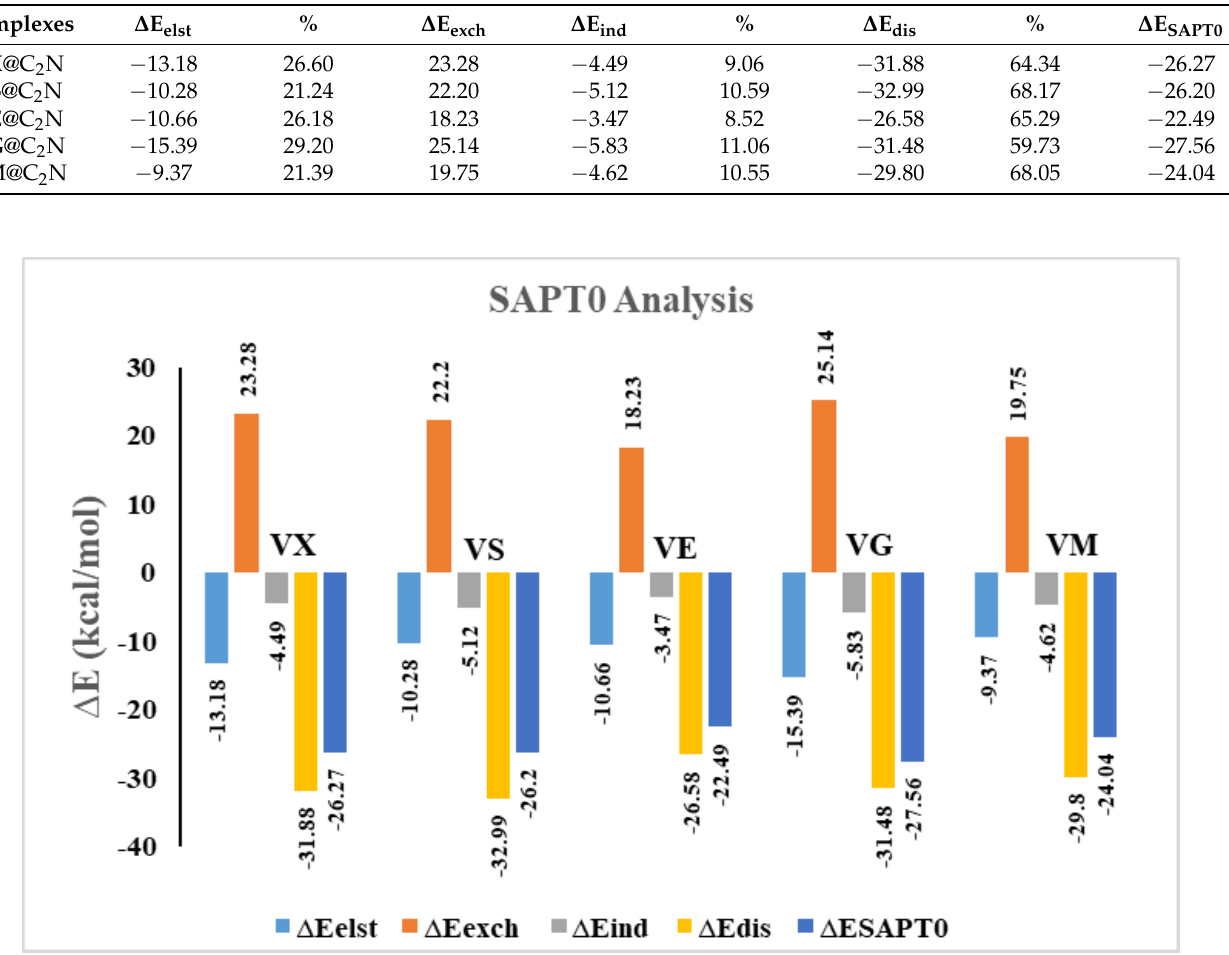
Table 3. SAPT0 analysis of V-series@C 2 N complexes (kcal/mol).